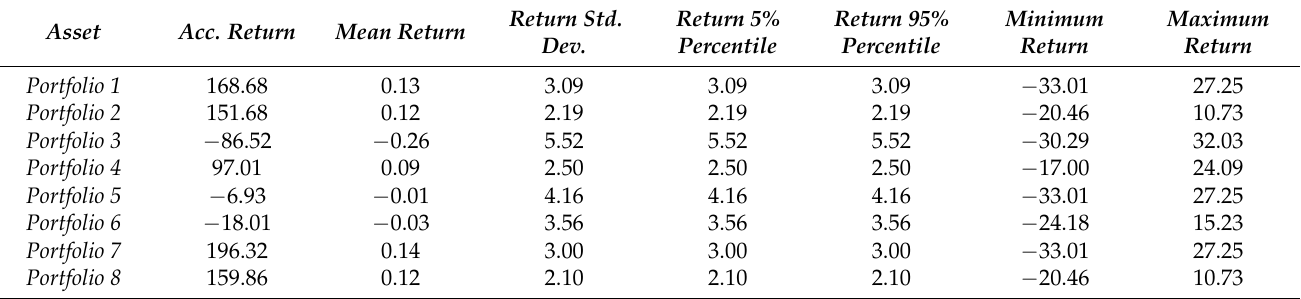
Table 6. Performance of the 8 simulated portfolios for a theoretical Institutional investor that pays a yearly 1% stock trading fee, in a monthly basis, and future trading roll-over costs.